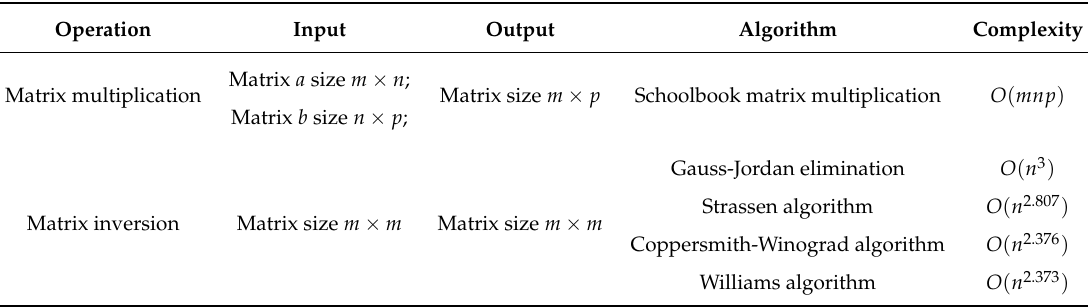
Table 1. Computation Complexity of Matrix Algebra.